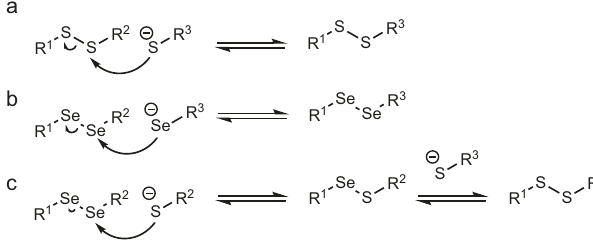
Fig. 2 DCC schemes. a Scheme of disul fi de exchange. b